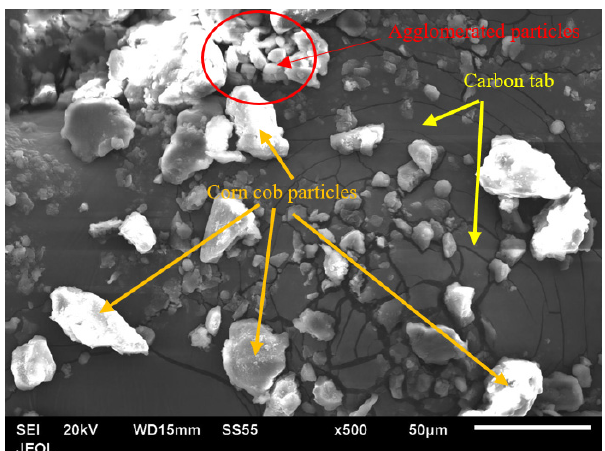
Figure 3. SEM image of corn cob particles after the grain milling process.